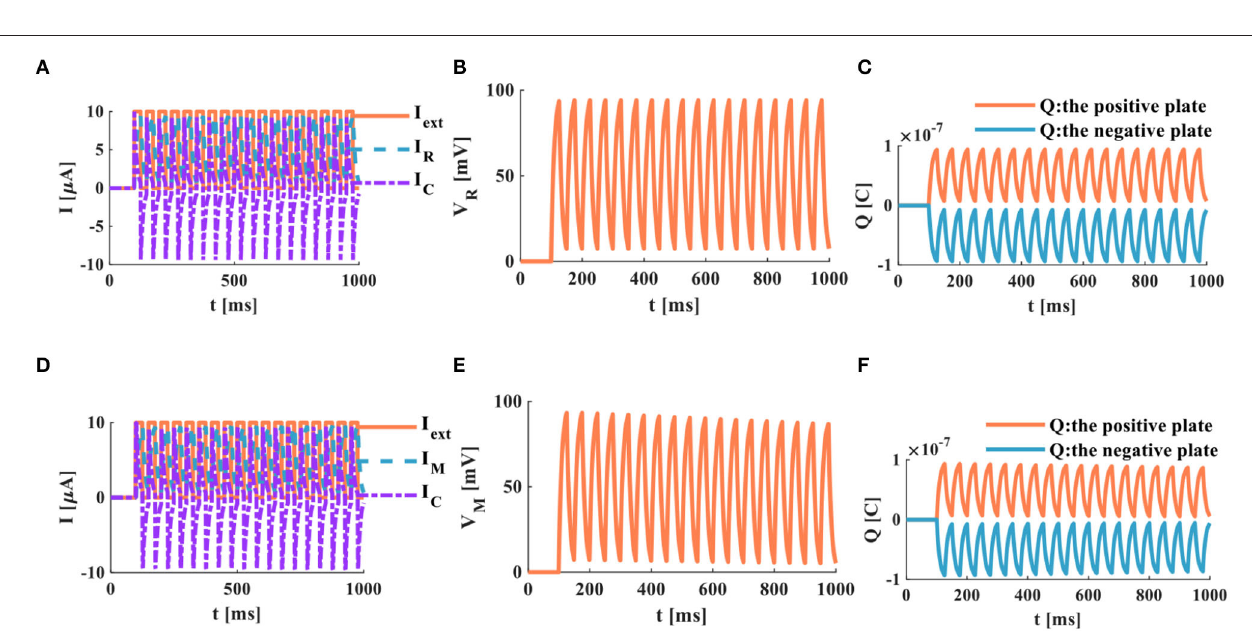
FIGURE 8 | A series of current pulses act on the RC and MC neuron circuits, (A) the current flows through the resistor R and the capacitor C, (B) the membrane potential of the RC circuit, (C) the charges on the positive and negative plates in the RC circuit, (D) the current flows through the memristor M and the capacitor C. (E) the membrane potential of the MC circuit, (F) the charges on the positive and negative plates in the MC circuit.